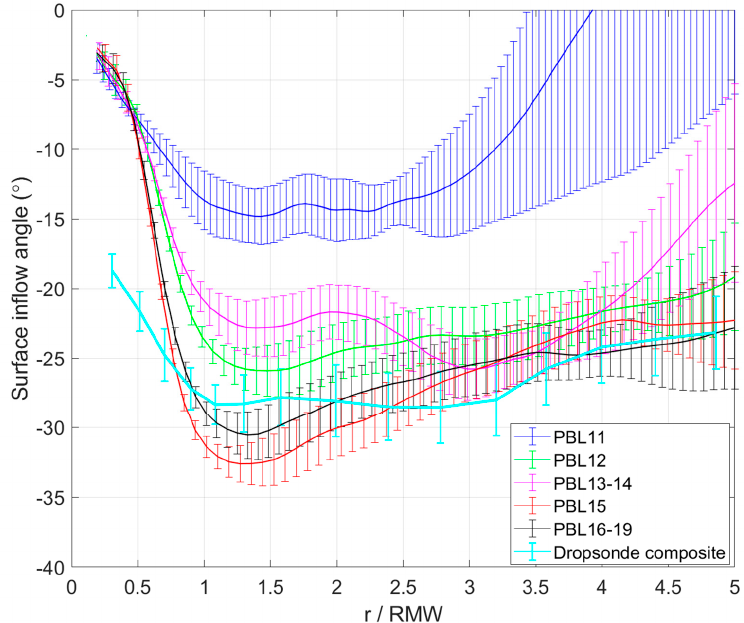
Figure 7. Plots of the azimuthally averaged surface inflow angle as a function of radius that is normalized by the radius of maximum wind speed (RMW) in the five idealized HWRF simulations. The dropsonde composite of the surface inflow angle is also shown. The error bar represents the 95% confidence interval.